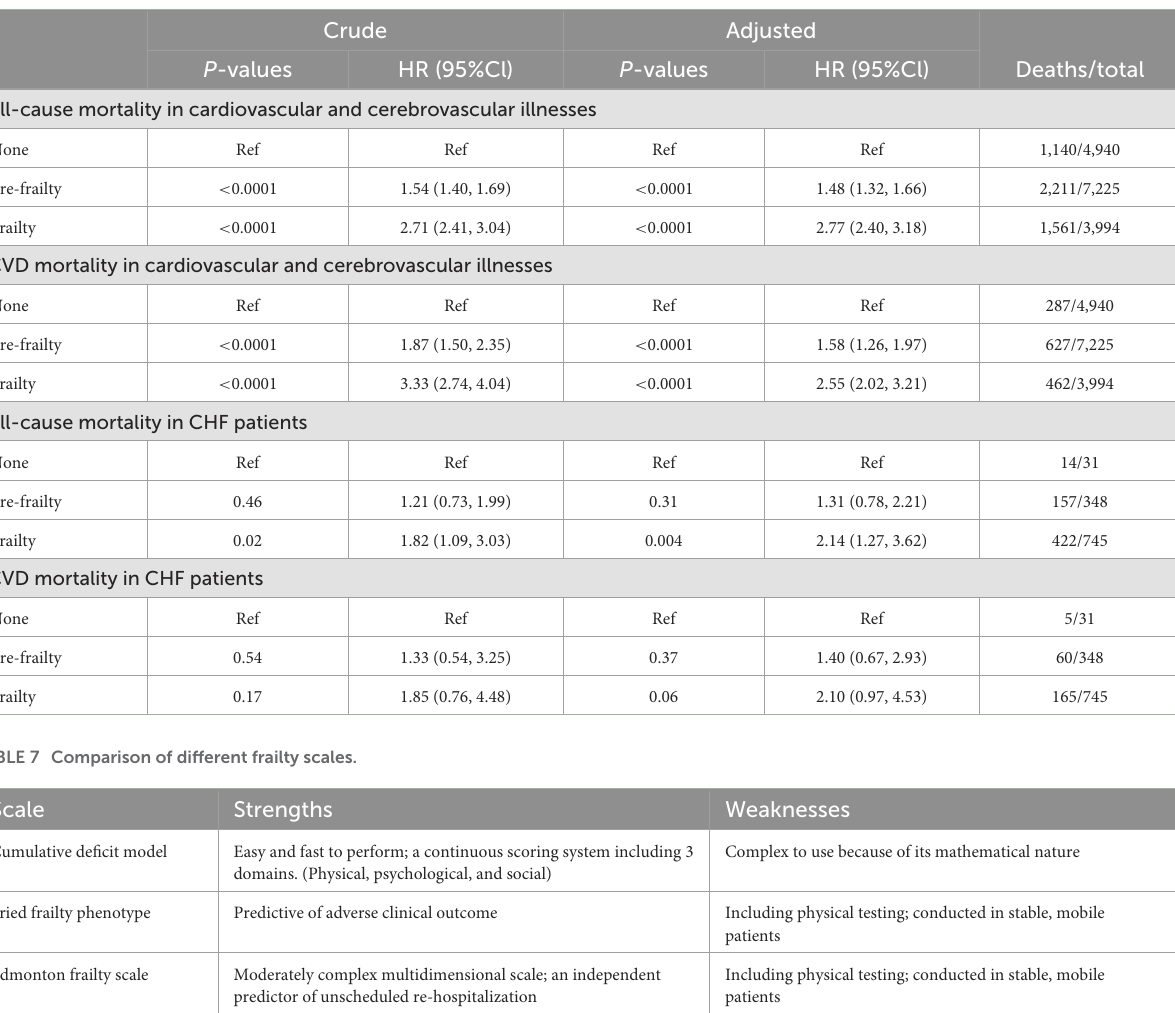
TABLE 6 All-cause mortality and CVD mortality in cardiovascular and cerebrovascular participants and CHF patients. Crude Adjusted P -values HR (95%Cl) P -values HR (95%Cl) Deaths/total